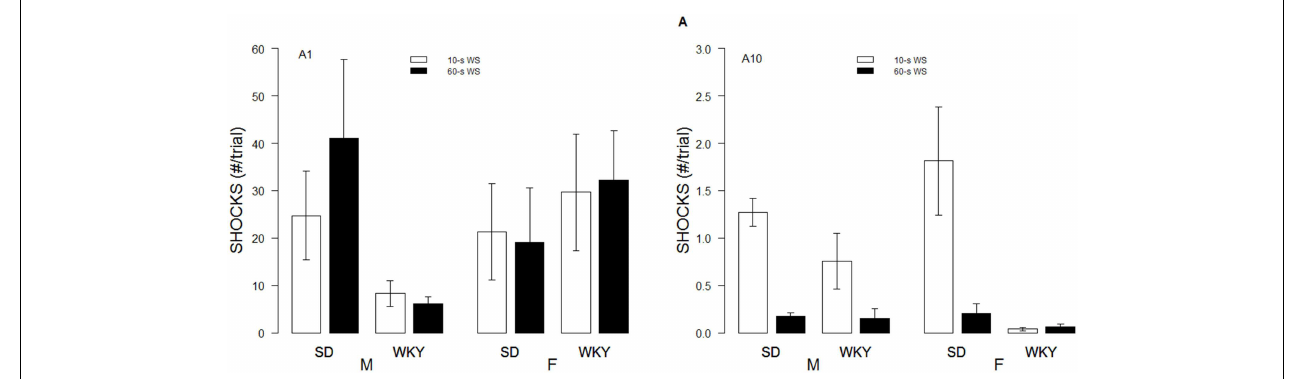
FIGURE 2 | Shocks experienced during acquisition. Shocks rates per trial are depicted for the first session (A1, left panel) and 10th session of acquisition (A10; right panel) as a function of strain, sex,